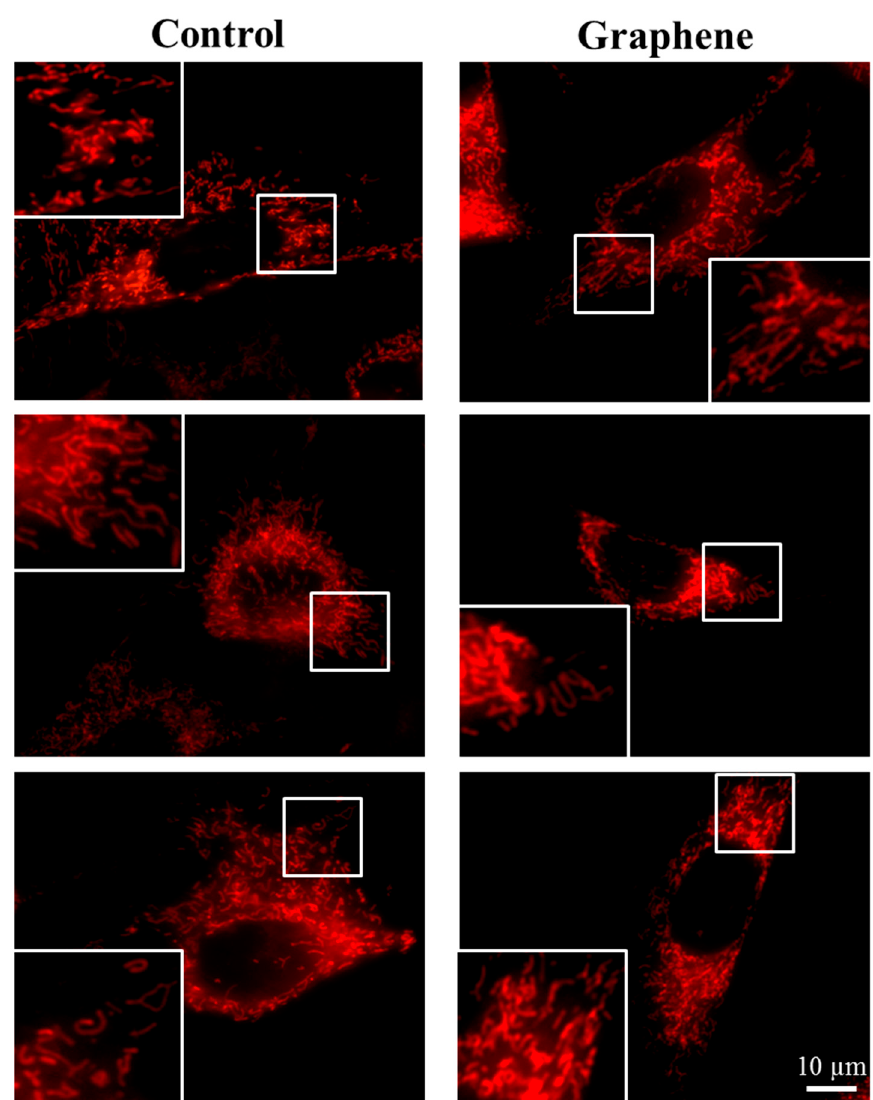
Figure 7. The morphology of mitochondrial network after staining with Mito Tracker Green FM and Mito Red Green fluorescence in living cells and red fluorescence in fixed cells. Magnification in squares presents different phenotypes of mitochondria: straight rods, twisted rods, branched rods and loops.